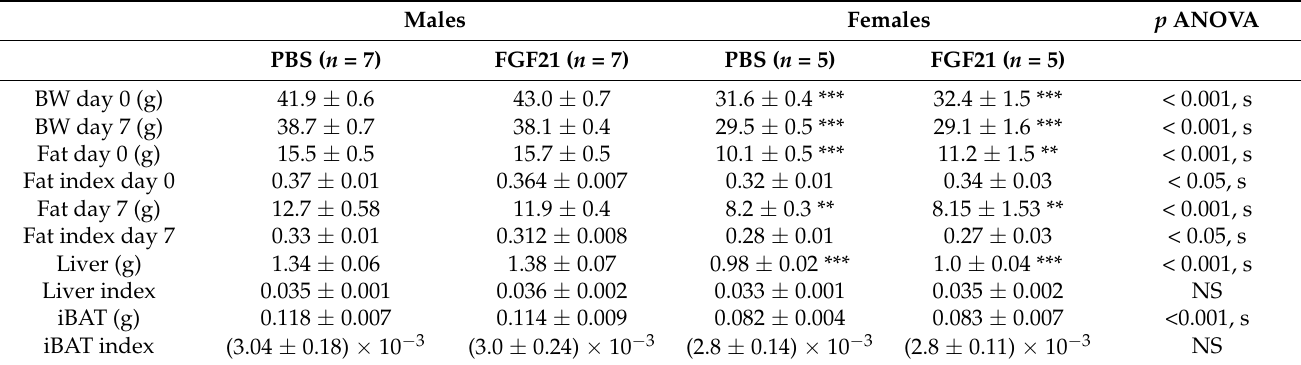
Table 1. Weight of body and organs in male and female mice administered PBS or FGF21.